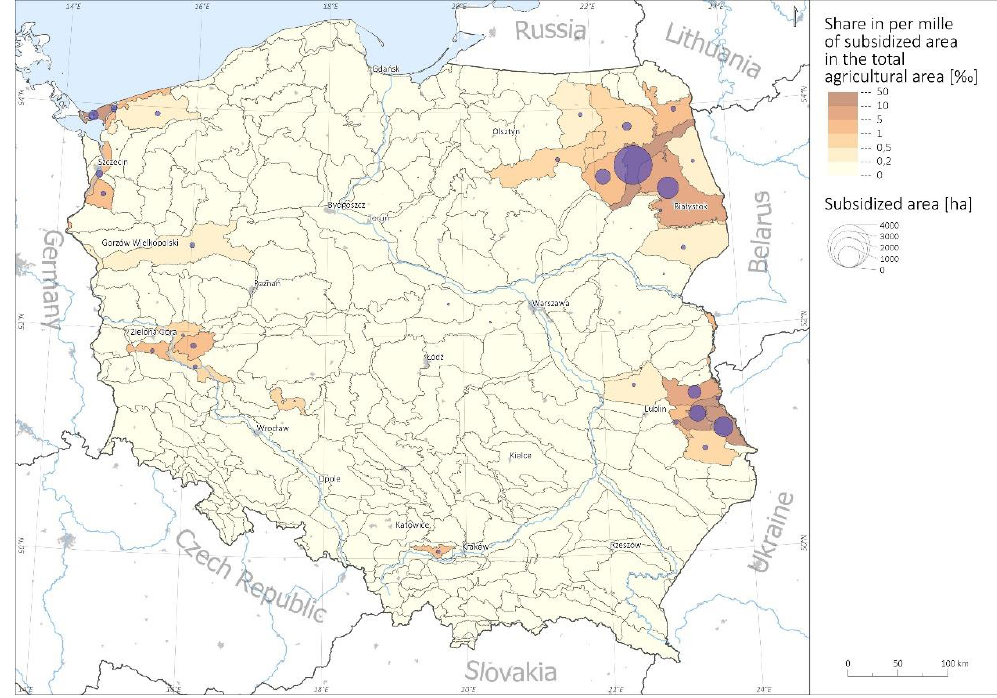
Figure 11. Area of land subsidised to support breeding habitats of the aquatic warbler and their share in the total agricultural area in mesoregions (Source: Authors based on ARMA data).